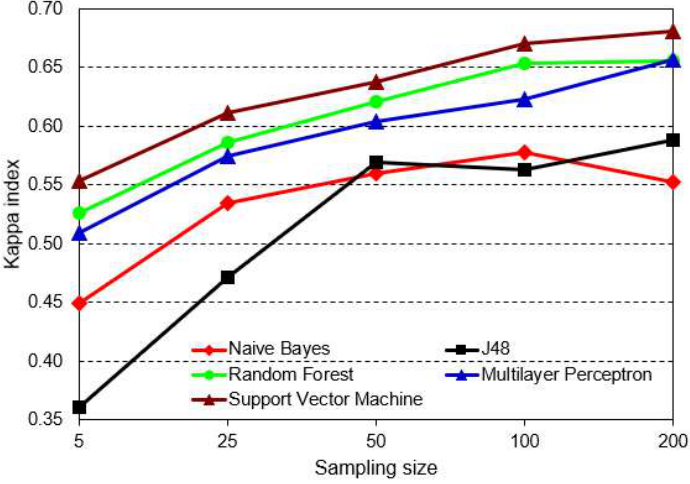
Figure 4. Kappa indices for different training sets and different classifiers. Table 1. Mean and standard deviation of Kappa indices for different training sets and different classifiers.